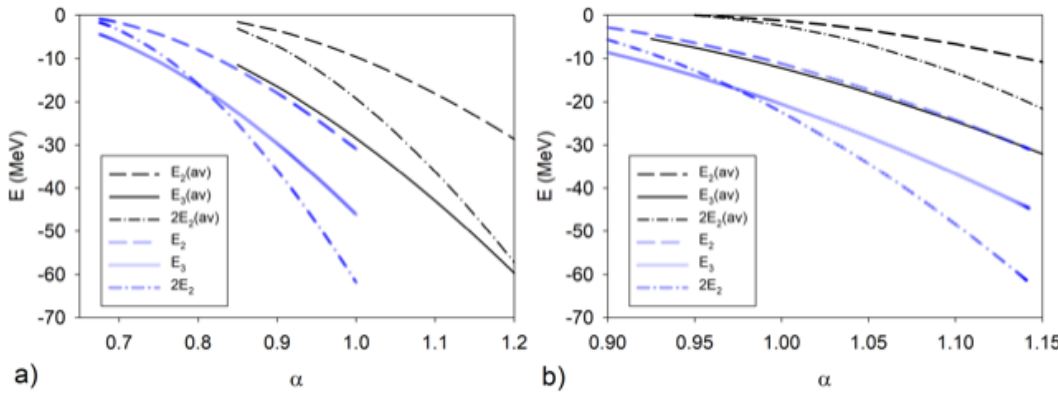
Figure 2: NN ¯ K system: the energies E (solid line) are shown as functions of the scaling factor α , V AY averaged (av) ¯ KN potentials, b) for sHW and sHW averaged (av) ¯ KN